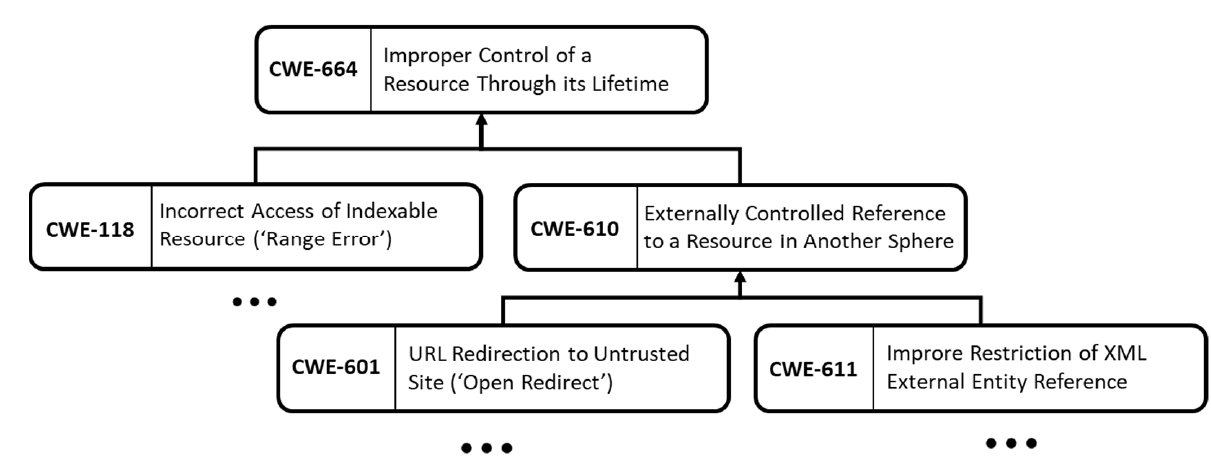
Figure 2. Example of CWE group with CWE-664.